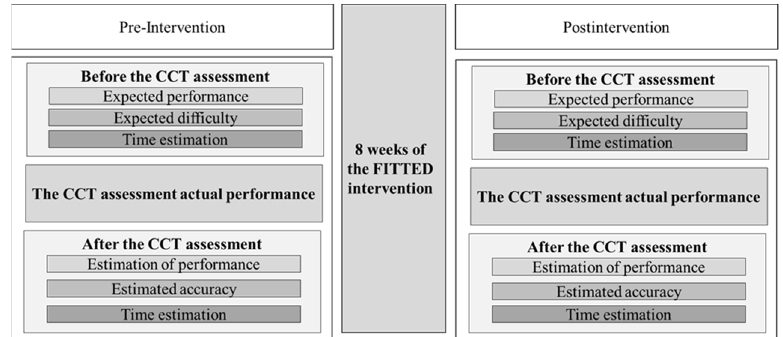
Figure 1. Study design.